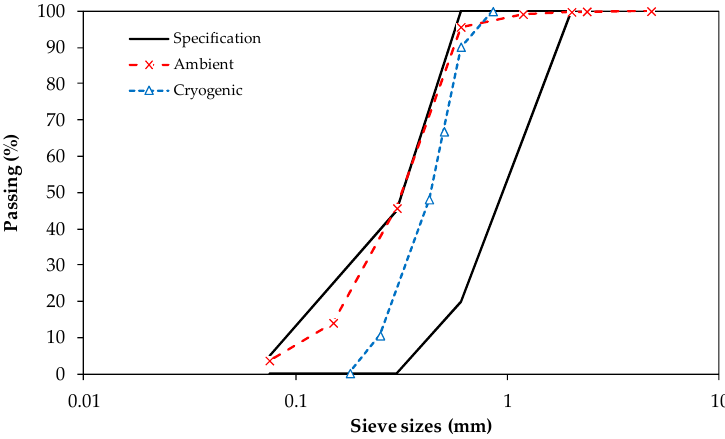
Figure 2. Crumb rubbers gradations.